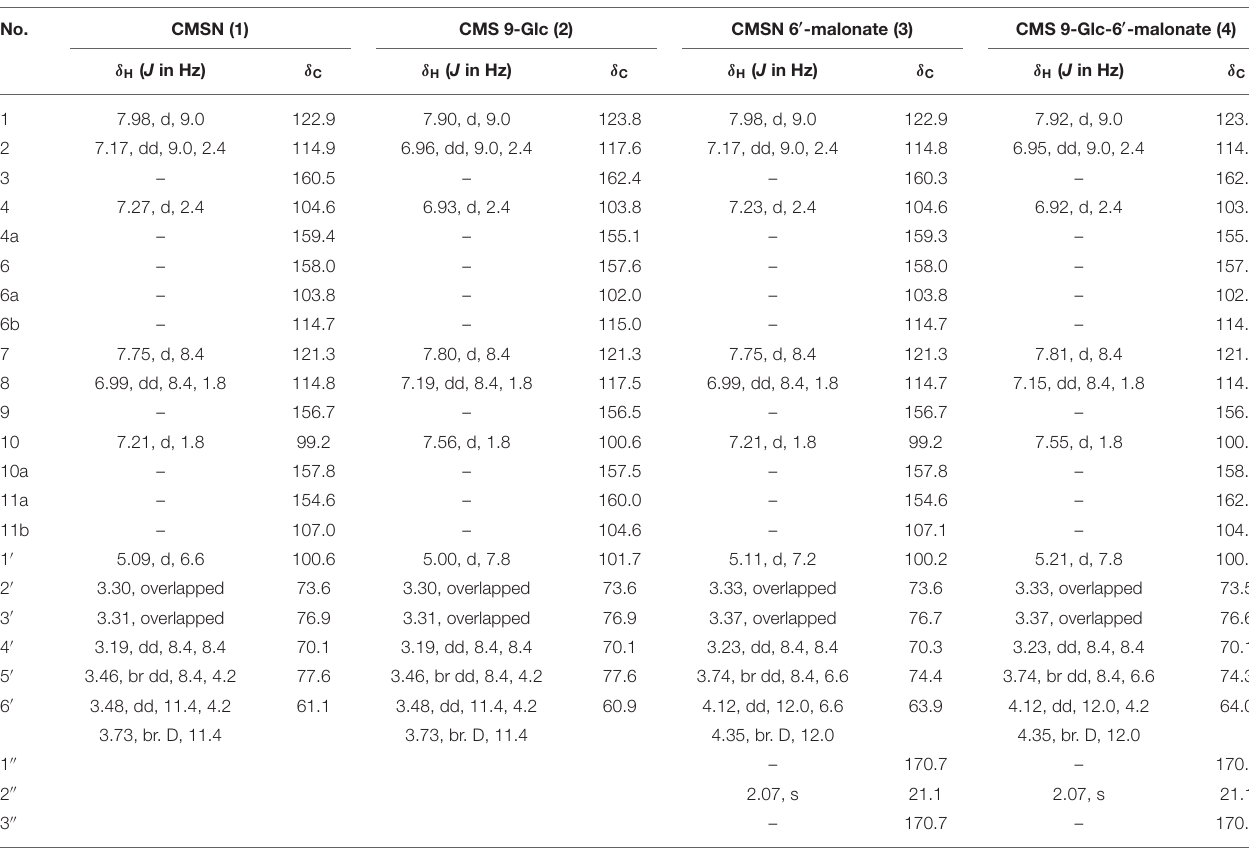
TABLE 2 | NMR analyses of the newly identified CMSN